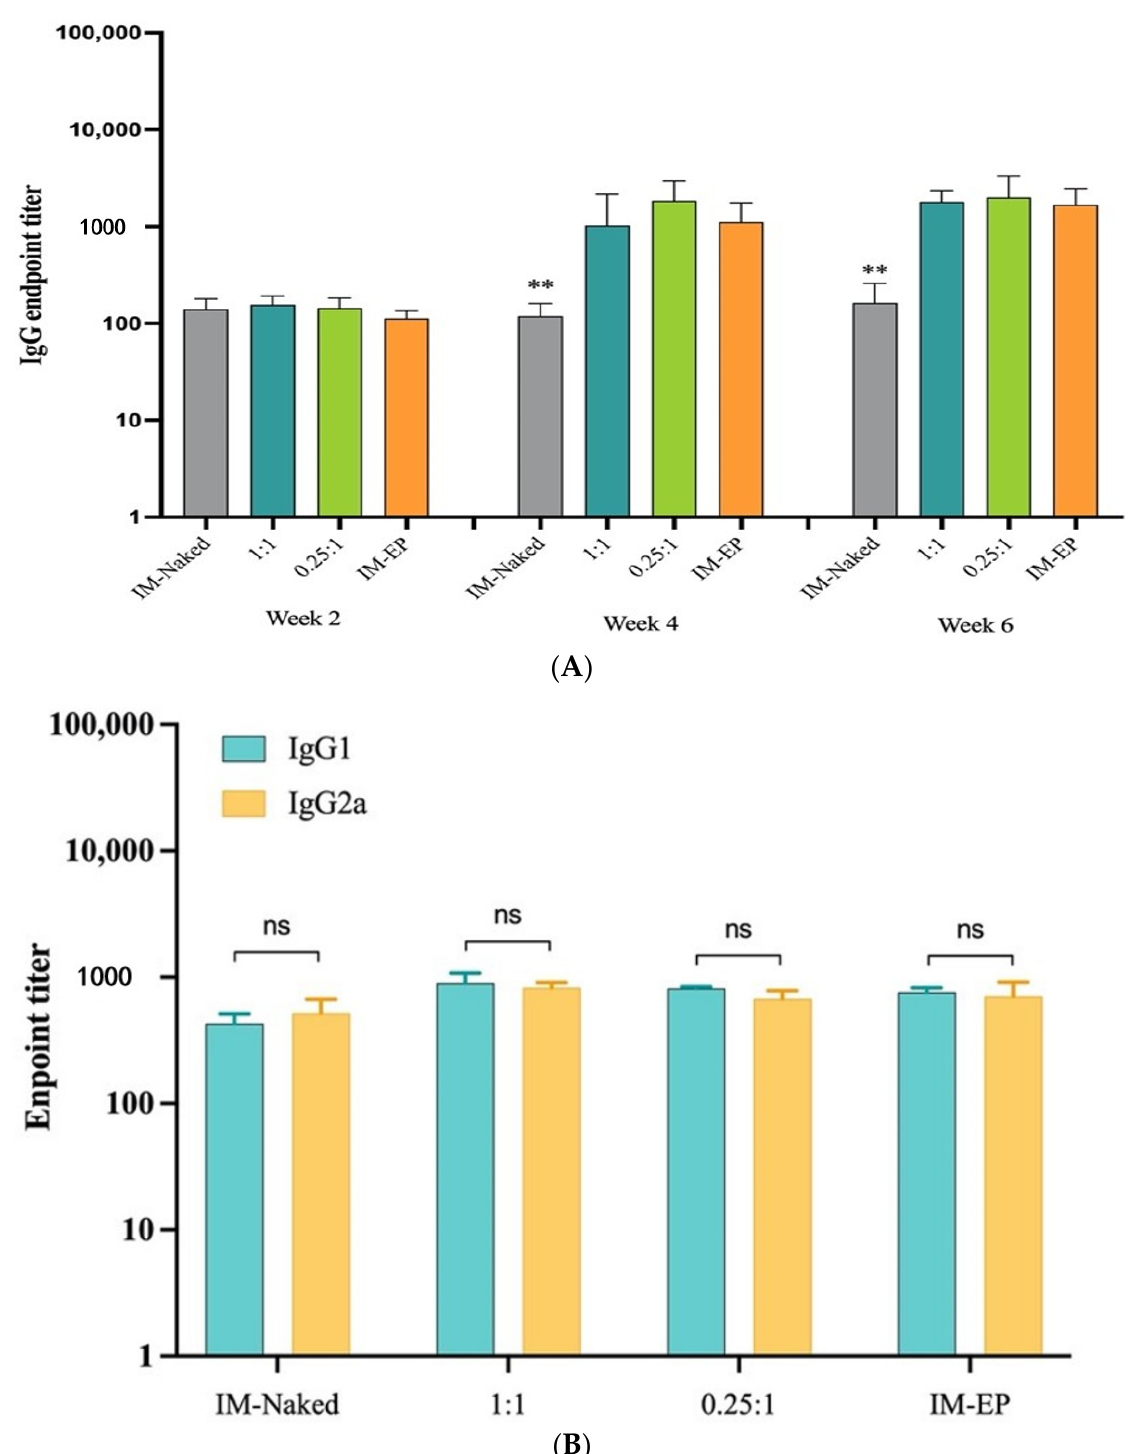
Figure 9. ( A ) Endpoint titers of SARS-CoV-2 spike-specific total IgG analyzed at weeks 2, 4, and 6 in mice immunized intramuscularly with naked pCMVkan-S (IM-naked), pCMVkan-S formulated with DOTAP4 at N/P ratios of 1:1 and 0.25:1, and by using electroporation device (IM-EP), ( B ) IgG subclass analysis; IgG1 and IgG2a in immunized mice sera collected on week 6. Data presented as mean ± SD of the endpoint titers in each vaccination group ( n = 5). ** indicate p < 0.01 when compared to other groups. ns: not statistically significant.